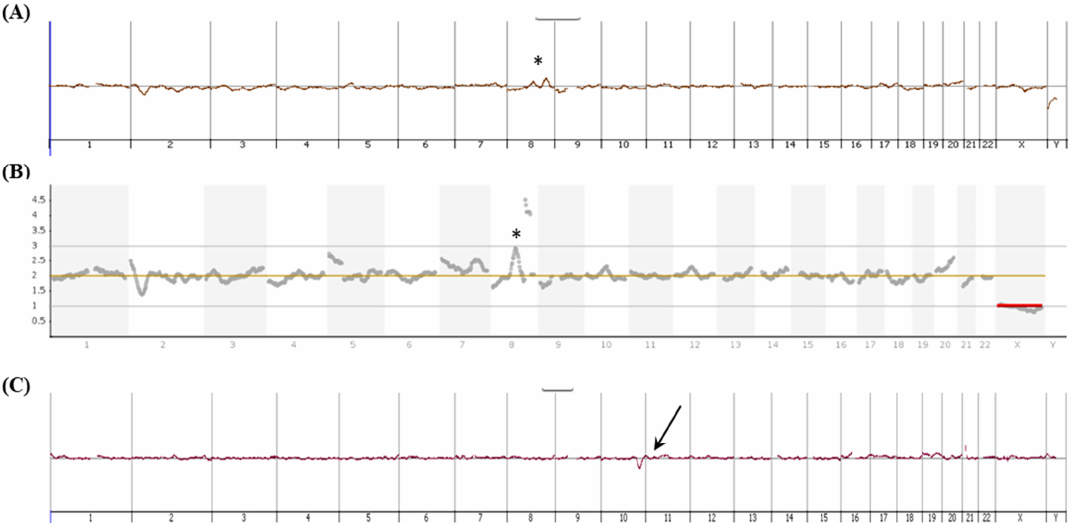
Figure 7. The molecular analyses for targeted cells enriched on and then captured from the Coral Chip. ( A ) The array comparative genomic hybridization (aCGH) and ( B ) the next generation sequencing (NGS) for the SK-BR-3 cancer cells. The recognizable genomic imbalance [42] in chromosome 8 was denoted by a star. ( C ) The aCGH for the circulating fetal cells with a de novo deletion in chromosome 10q25.2q26.12 (i.e., the case 2 in Table 2). The 10q25.2q26.12 deletion is indicated by an arrow. The DNA used for the molecular analyses was extracted from 4–5 captured cells and then amplified by the PicoPLEX Single Cell WGA Kit (Takara Bio, Mountain View, CA, USA).